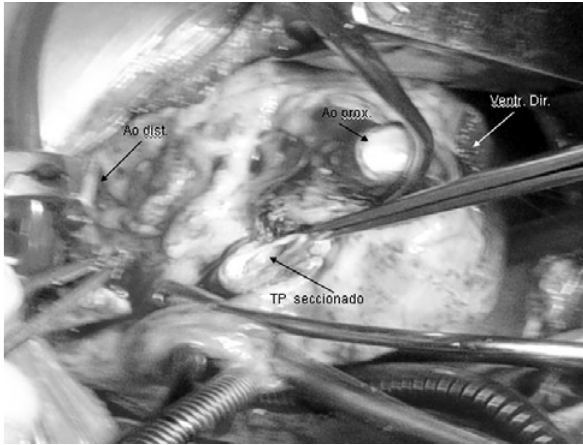
Fig. 4 - Fotografia cirúrgica. Observa-se a secção transversa de aorta (Ao), mostrando os seus cotos proximal (Ao prox.) e distal (Ao distal). O tronco pulmonar (TP) hipoplásico está sendo seccionado acima de seu plano valvar. Ventriculotomia direita (Ventr. Dir)